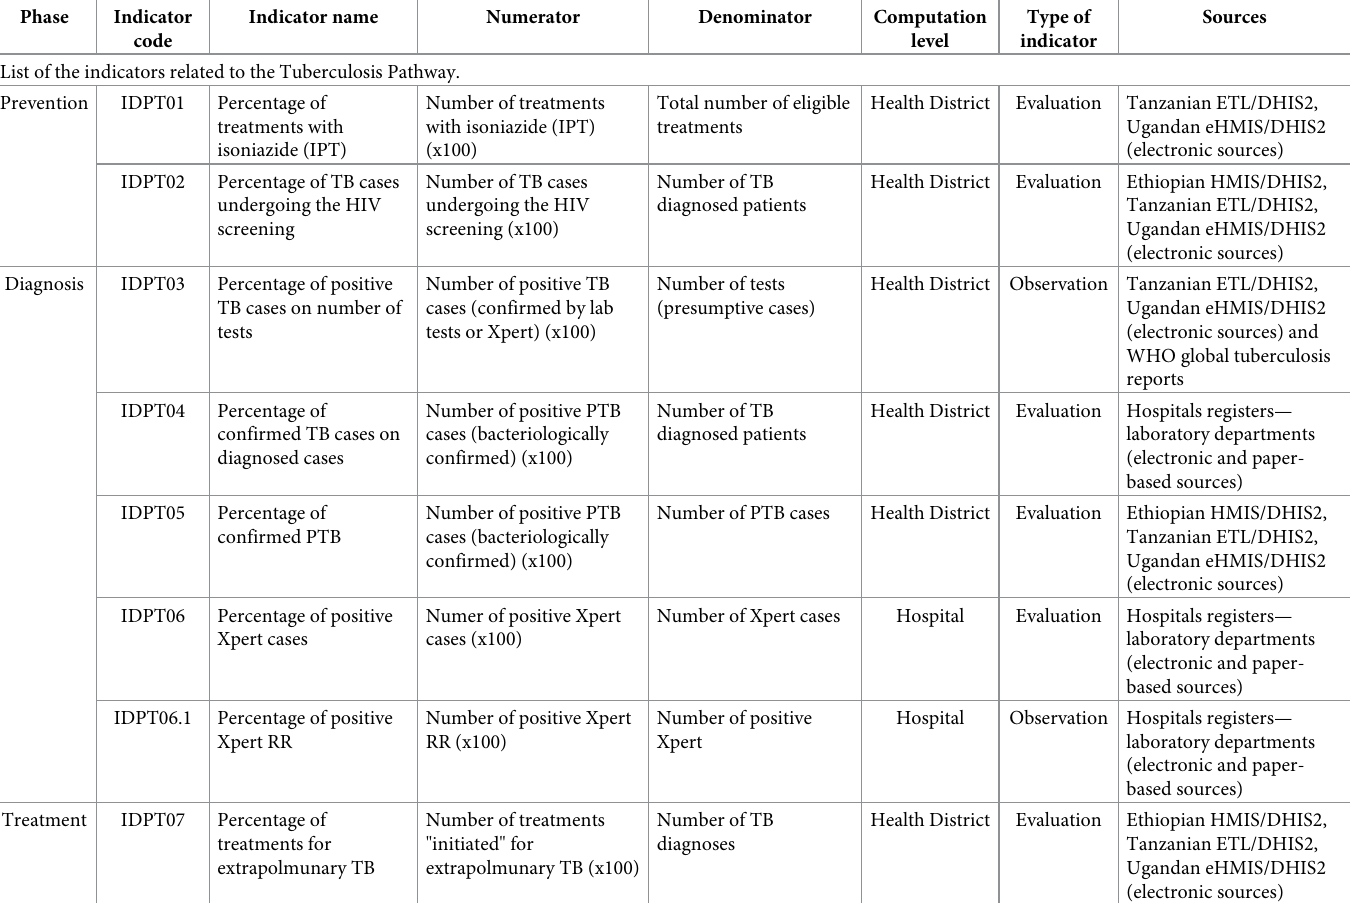
Table 1. List of the indicators included into the CDs care pathways: Tuberculosis, gastroenteritis and HIV/AIDS. Phase List of the indicators related to the Tuberculosis